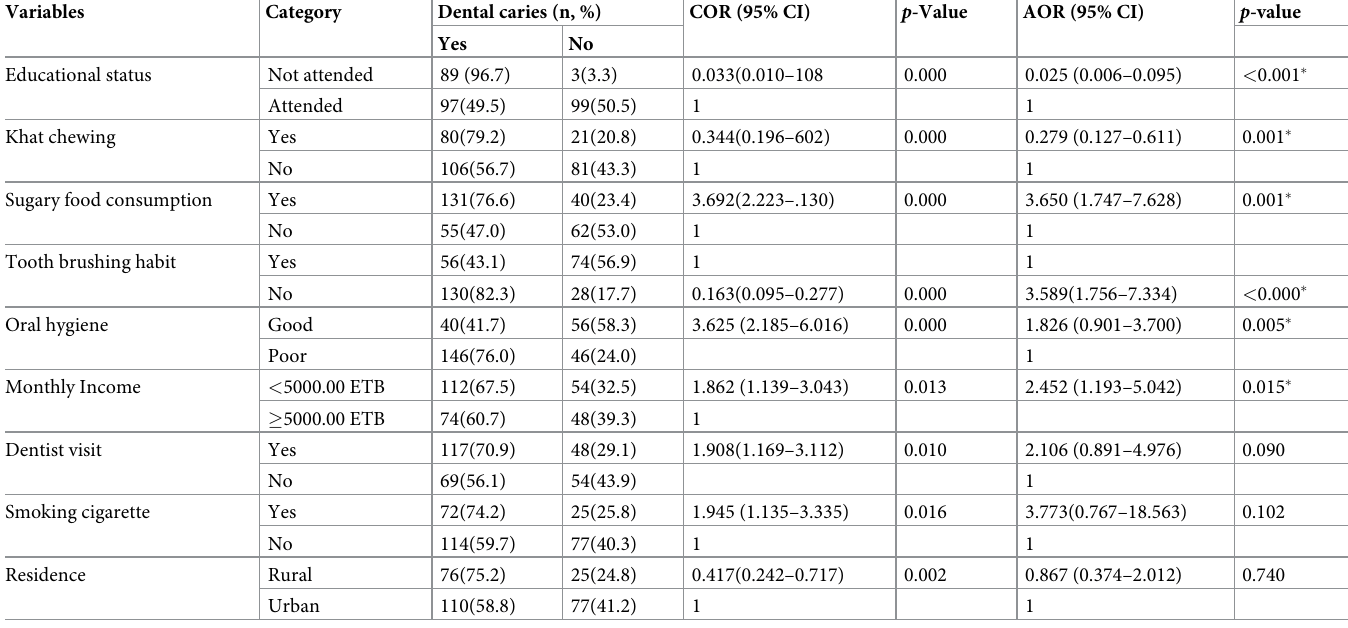
Table 2. Bivariate and multivariable analysis of factors that can predict dental caries among patients attending the dental clinic of Shashamane Comprehensive Spe- cialized Hospital.